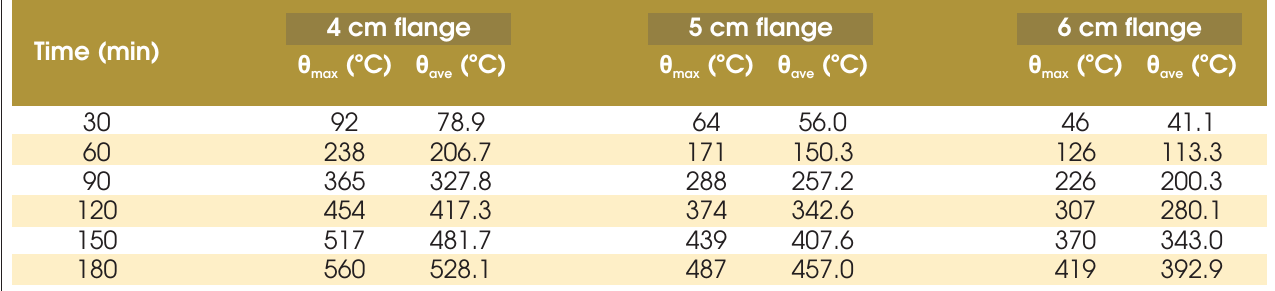
Table 5 – Maximum and average temperatures on slab upper face with flange between 4 and 6 cm